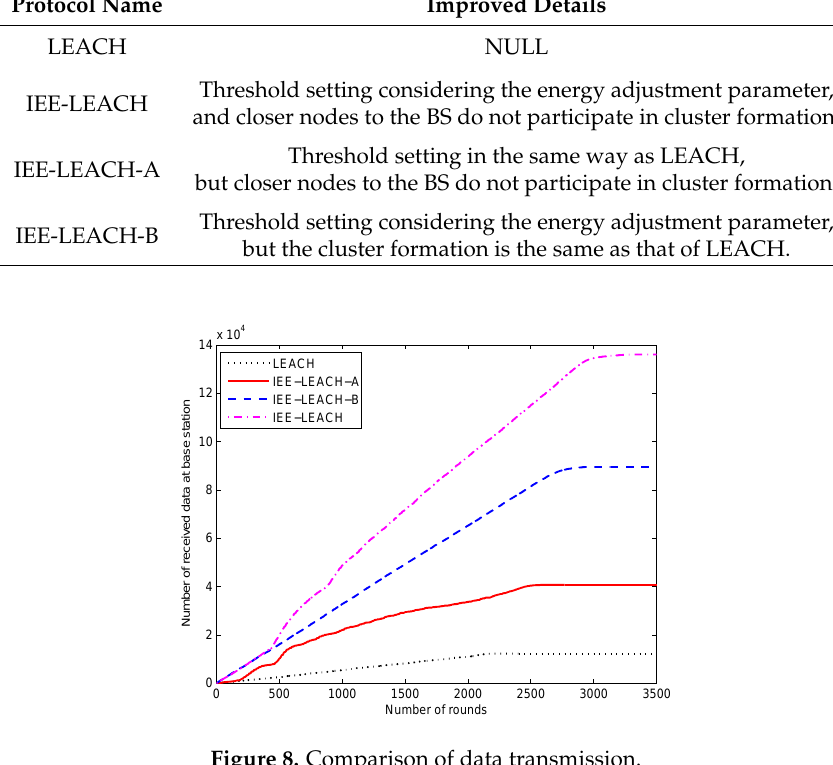
Figure 8. Comparison of data transmission.